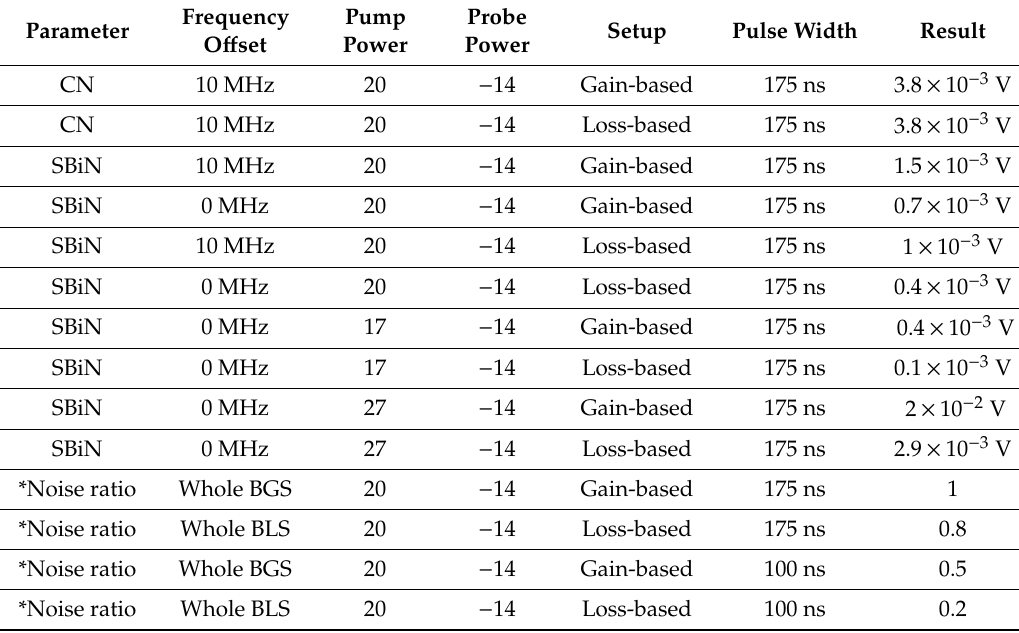
Table 2. Summary of the experimental noise